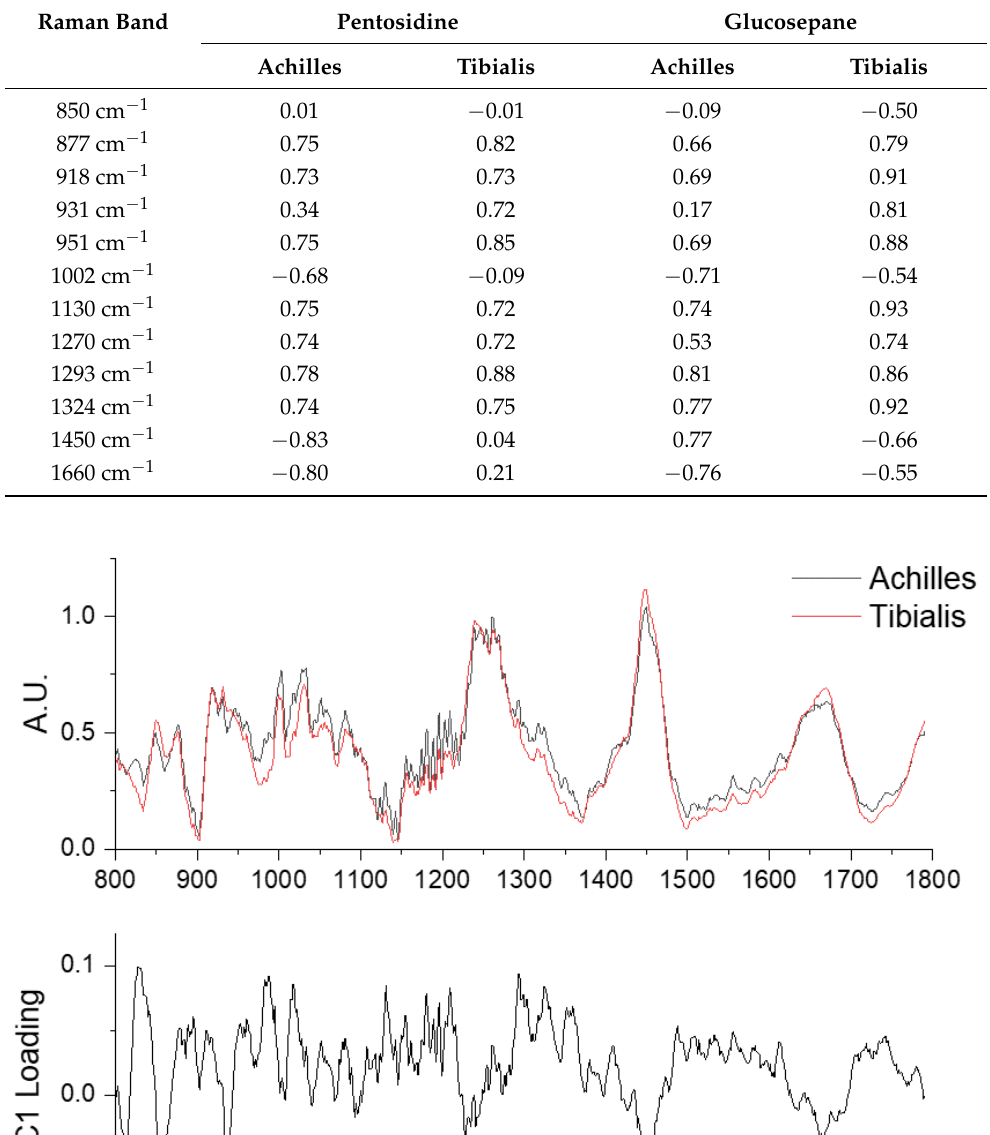
Table 1. Pearson’s correlation coefficients between Raman band intensities and biochemical assays of human Achilles and tibialis anterior tendons.